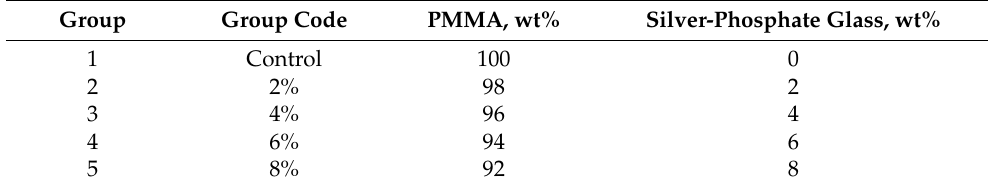
Table 1. Composition of